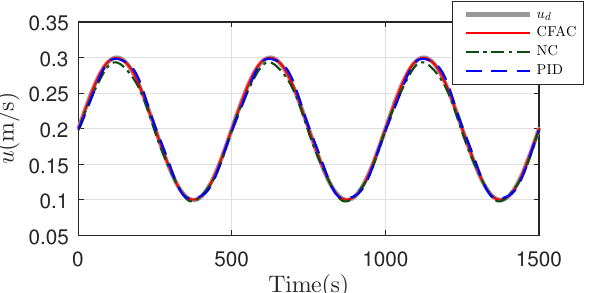
Figure 16. Velocity tracking performance in floating motion with a variable velocity and constant pitch angle